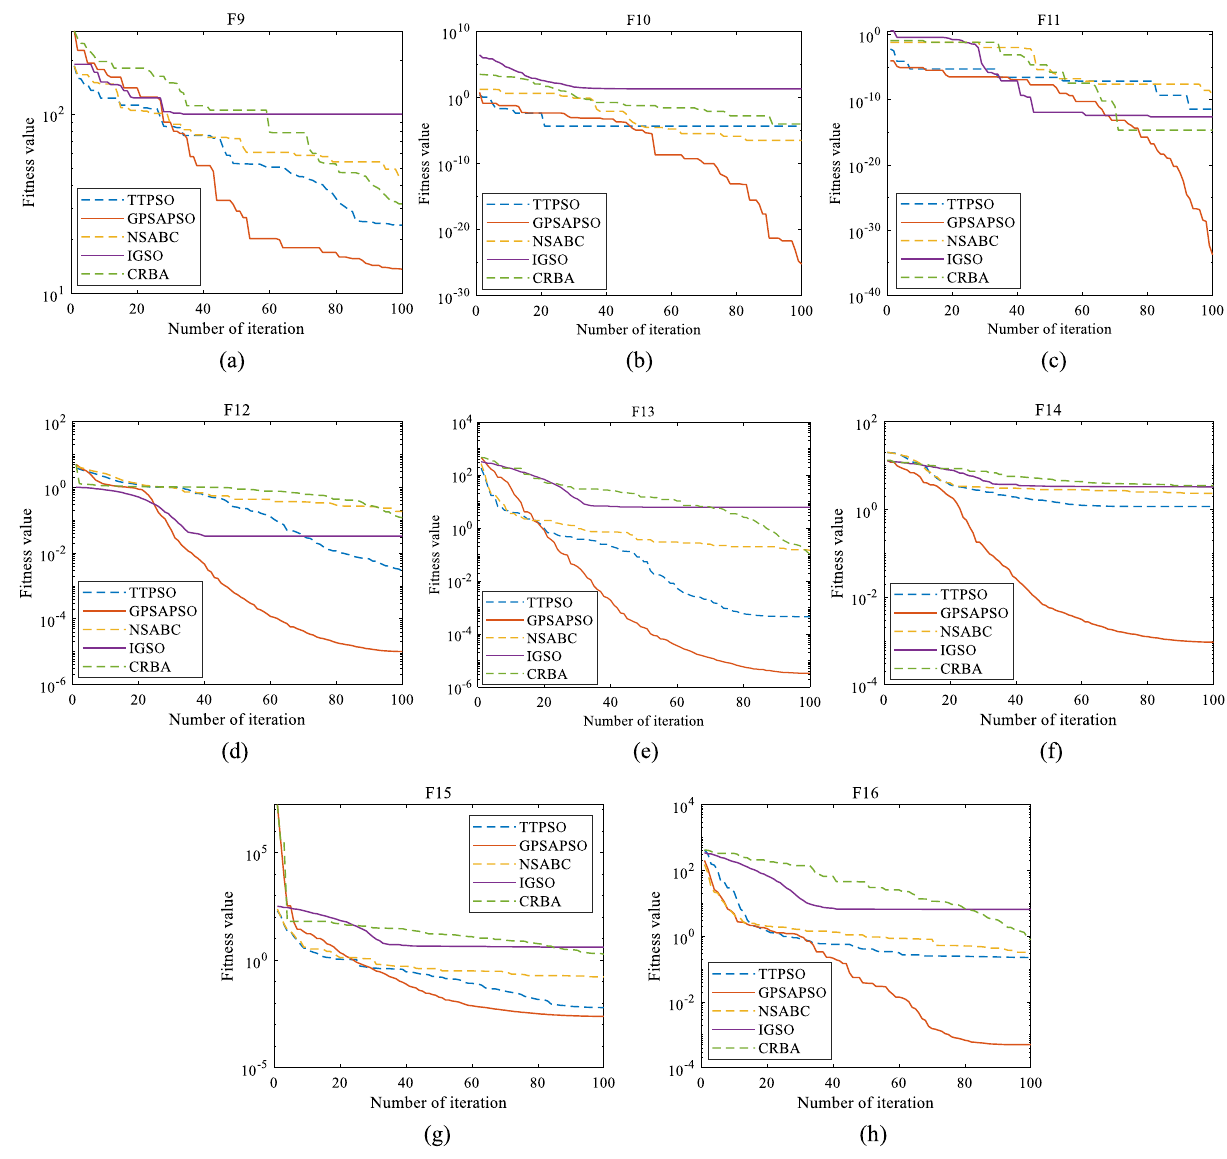
Figure 6. Iterative process of high-dimensional function.